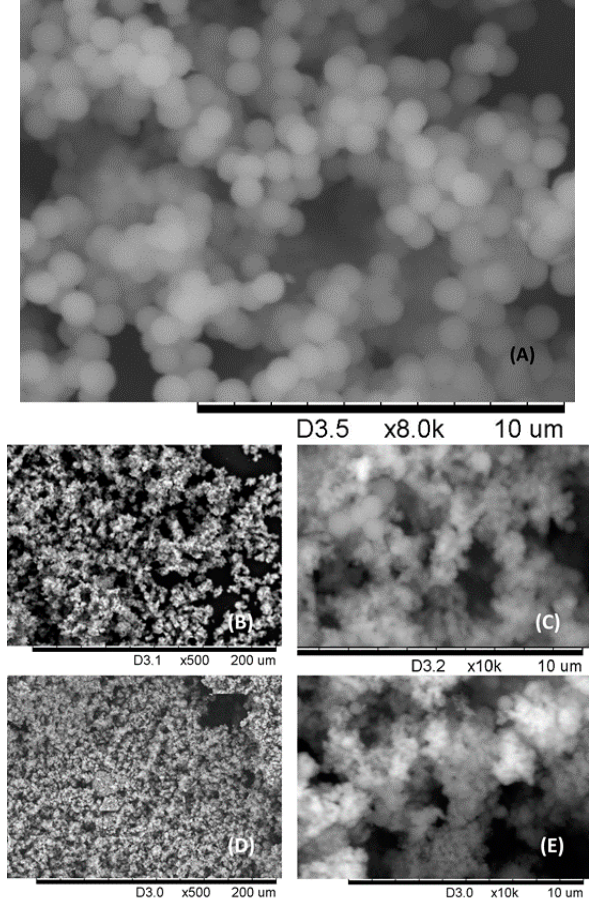
Figure 1. Scanning electron microscope (SEM) images of the: ( A ) Fe 3 O 4 /SiO 2 spherical aggregates of nanoparticles; ( B , C ) Fe 3 O 4 /SiO 2 -NH 2 nanocomposites; ( D , E ) Fe 3 O 4 /SiO 2 -NH 2 -DTPA nanocomposites